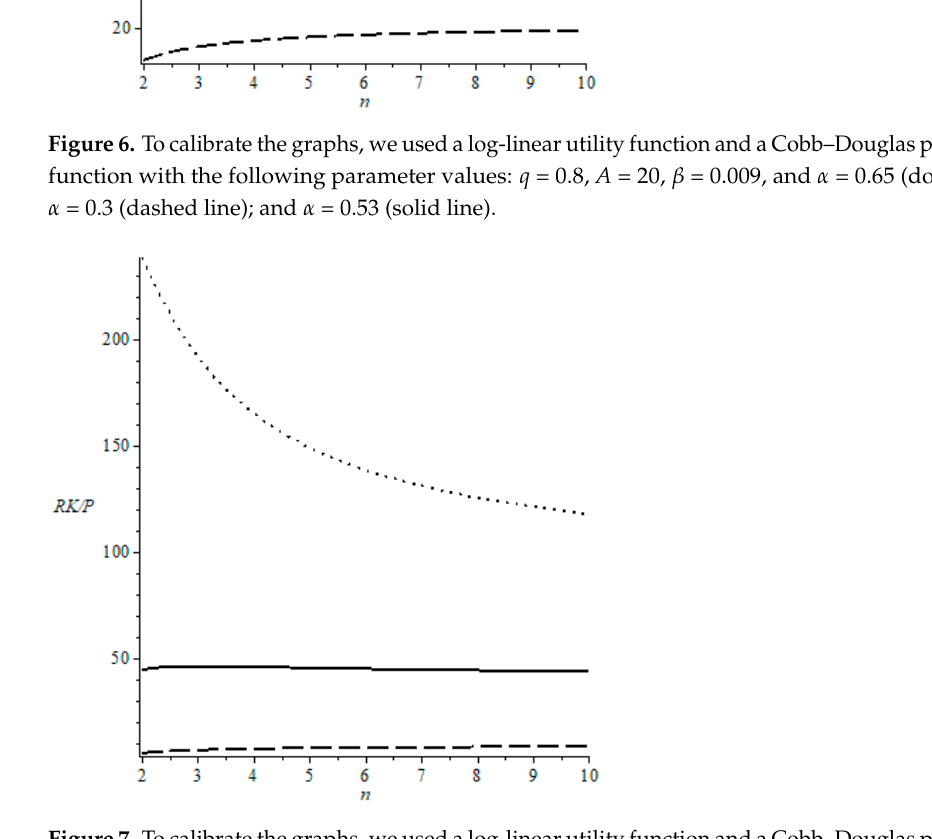
Figure 7. To calibrate the graphs, we used a log-linear utility function and a Cobb–Douglas production function with the following parameter values: q = 0.8, A = 20, β = 0.009, and α = 0.65 (dotted line); α = 0.3 (dashed line); and α = 0.53 (solid